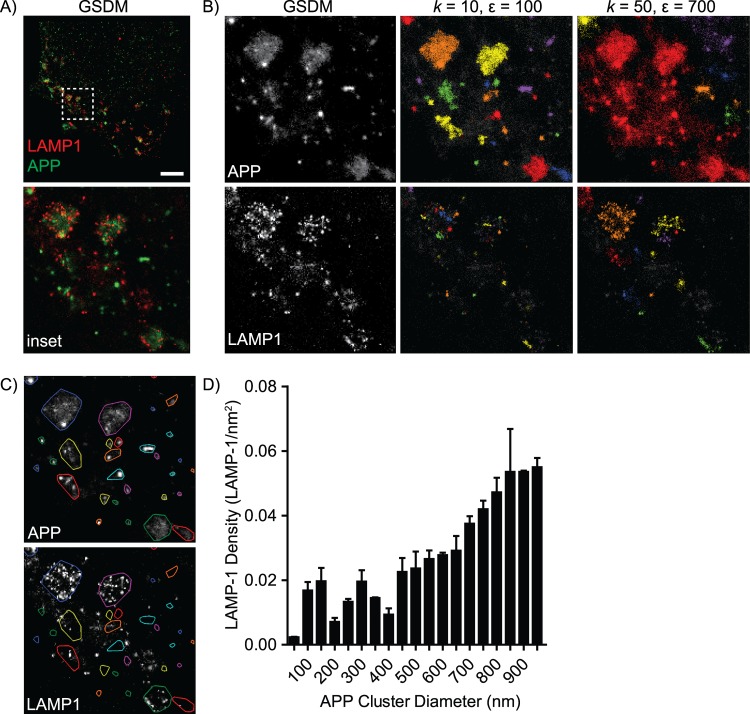
Quantification of the lysosomal marker LAMP1 in APP vesicles using the DBSCAN algorithm.(A) GSDM image analyzed in panels B-D. All analyses are performed on the region within the insert. (B) Identification of clusters using the DBSCAN algorithm using two different values for minimum cluster size (k) and neighbourhood size (ε), with individual clusters identified by color. (C) Top: Regions of Interest (ROIs) defined by the edge points of APP clusters identified using DBSCAN values of k = 10 and ε = 100; individual clusters are identified by color. Bottom: APP-defined ROIs overlaid on LAMP1 staining. (D) Quantification of LAMP1 density inside of APP clusters versus APP cluster sizes. Images are representative of, and graph quantifies, images from 3 experiments with a minimum of 4 images per experiment. Data is presented as mean ± SEM.